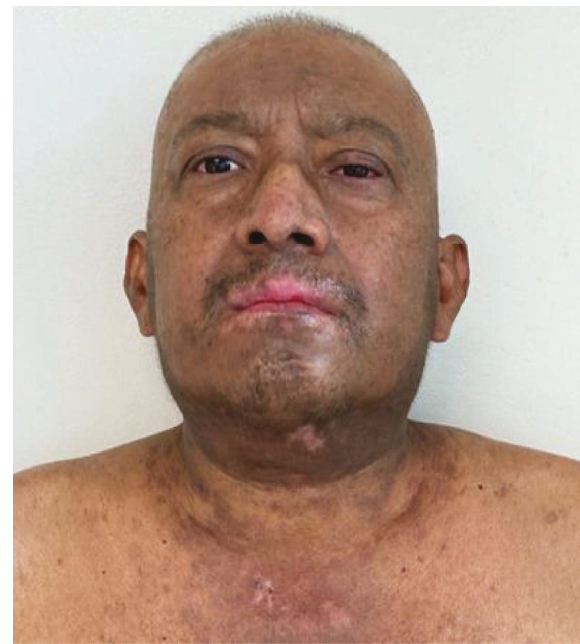
Figure 6: Resolution of oral and mucocutaneous involvement after four months of